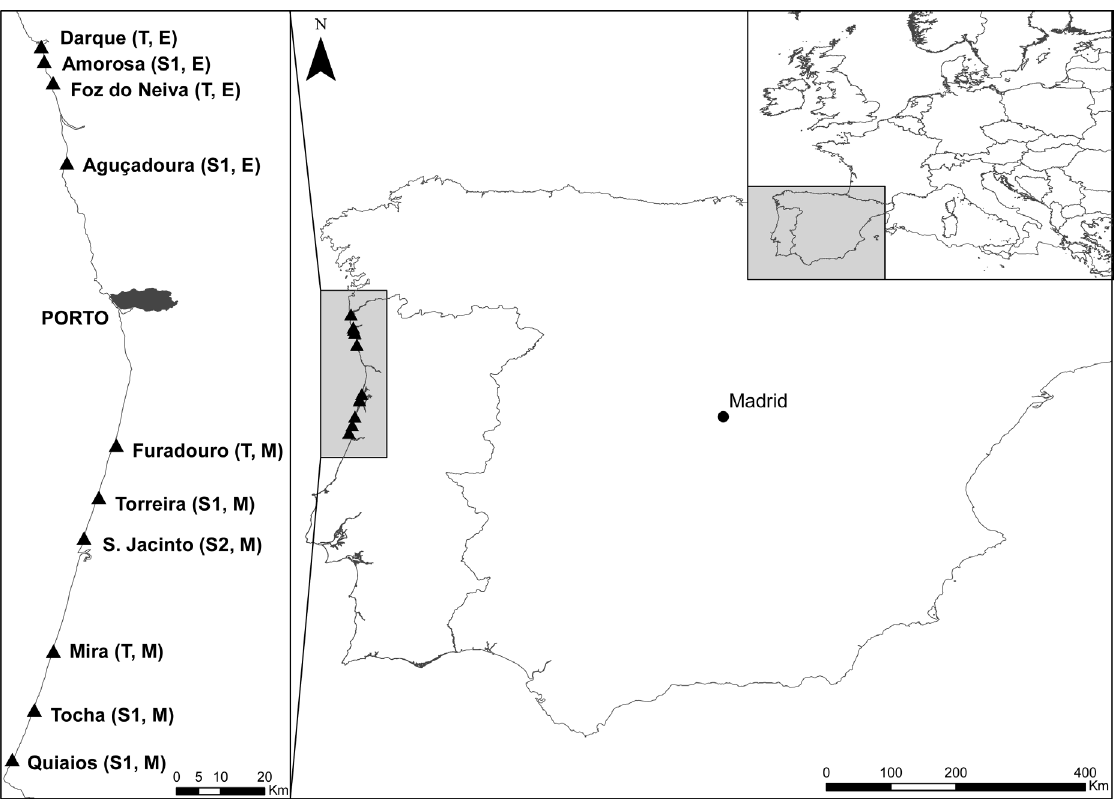
Figure 1. Location of the studied area in the Iberian and European contexts (right), with sampling sites indicated along the coastline (left). Prevailing dynamics (S1: (meta-) stable; S2: progradant; T: transgressive) and biogeographic location (E: Eurosiberian; M: Mediterranean) are indicated for each